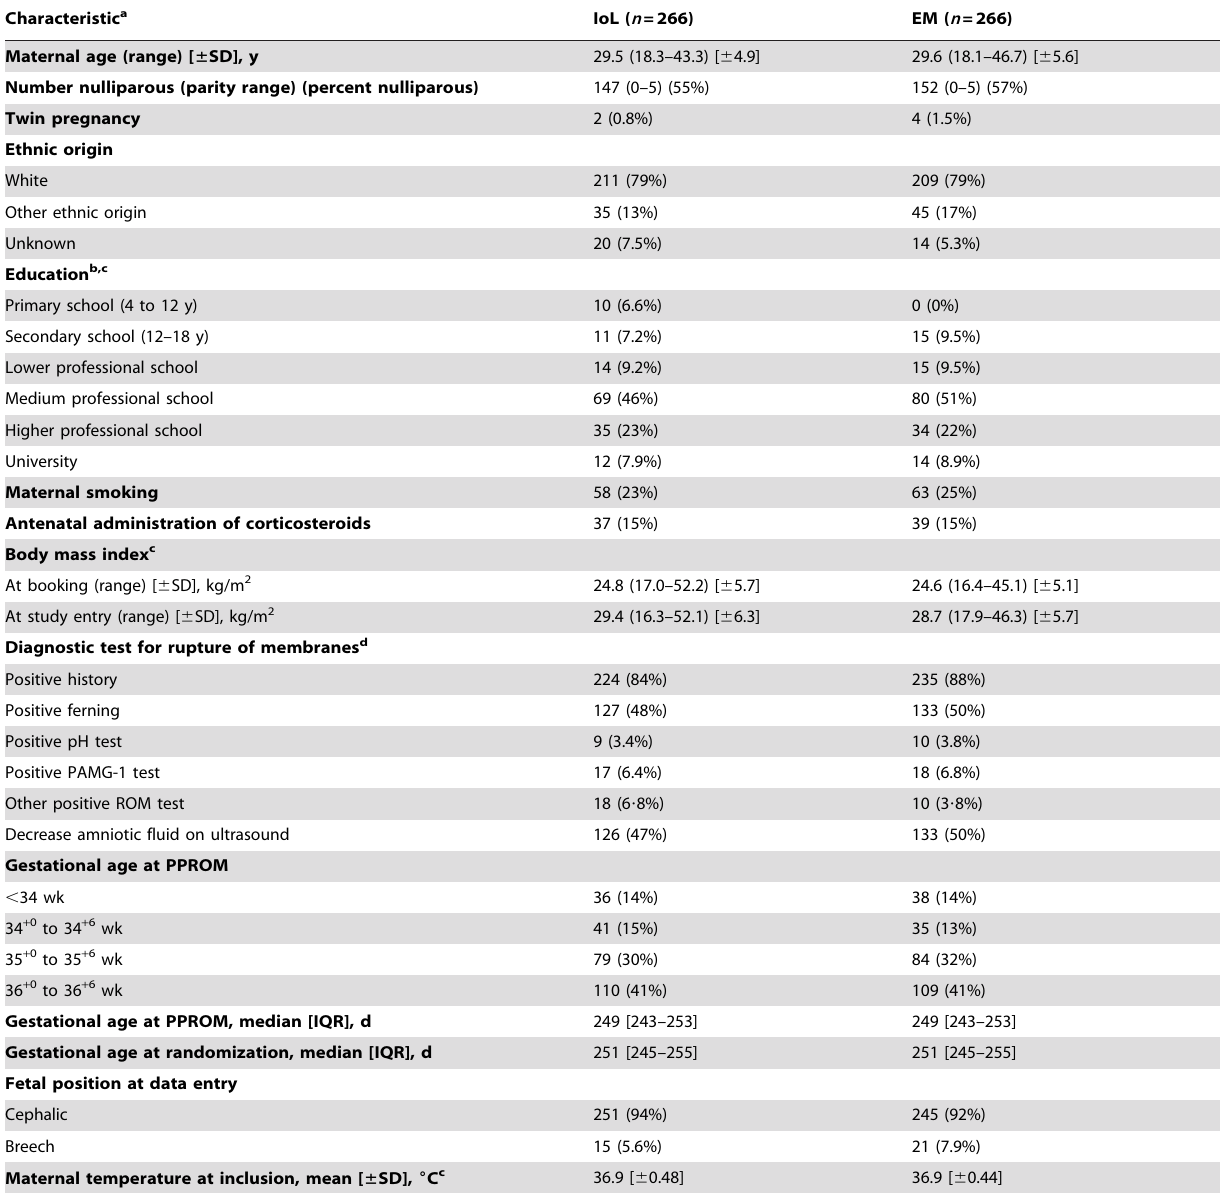
Table 1. Baseline